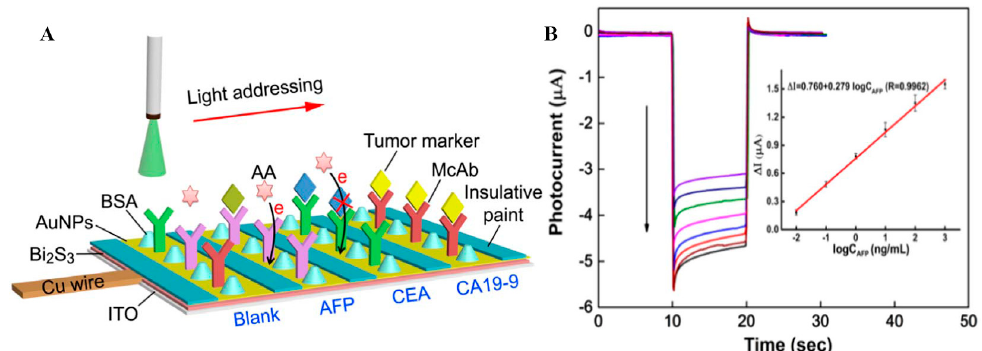
Figure 7. ( A ) Schematic representation for the rapid detection of multiple biomarkers on a single PEC sensor. ( B ) Photocurrent responses and calibration plot (inset) of AFP detection at concentrations of 1000, 100, 10, 1.0, 0.1, 0.01, 0.005, and 0 ng mL − 1 (from top to bottom). Reproduced from [59] with permission from Elsevier.